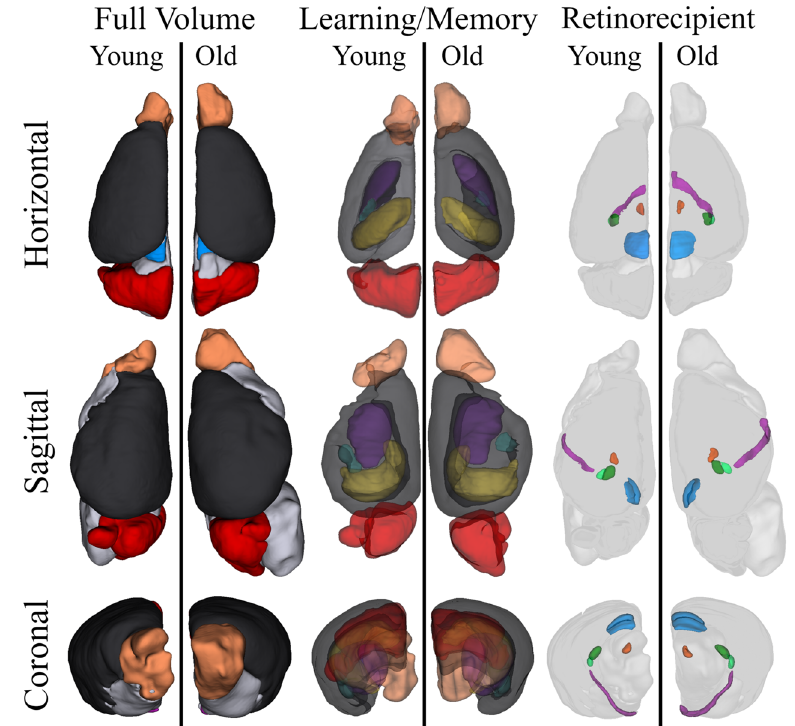
Fig. 7 Three-dimensional volume rendering of learning/memory and retinorecipient non-image forming visual regions in young and old mice. Volumes for the cortex (black), olfactory bulb (light orange), hippocampus (yellow), amygdala (teal), caudate nucleus (dark purple), cerebellum (red), superior colliculus (blue), geniculate complex (dorsal, dark green; ventral, light green), habenula (dark orange) and the optic tract (light purple) are shown in three orientations. The brains of the two age groups are represented in identical proportions to demonstrate the relative size differences between visual structures. Most notably, a greatly enlarged optic tract is observed within older